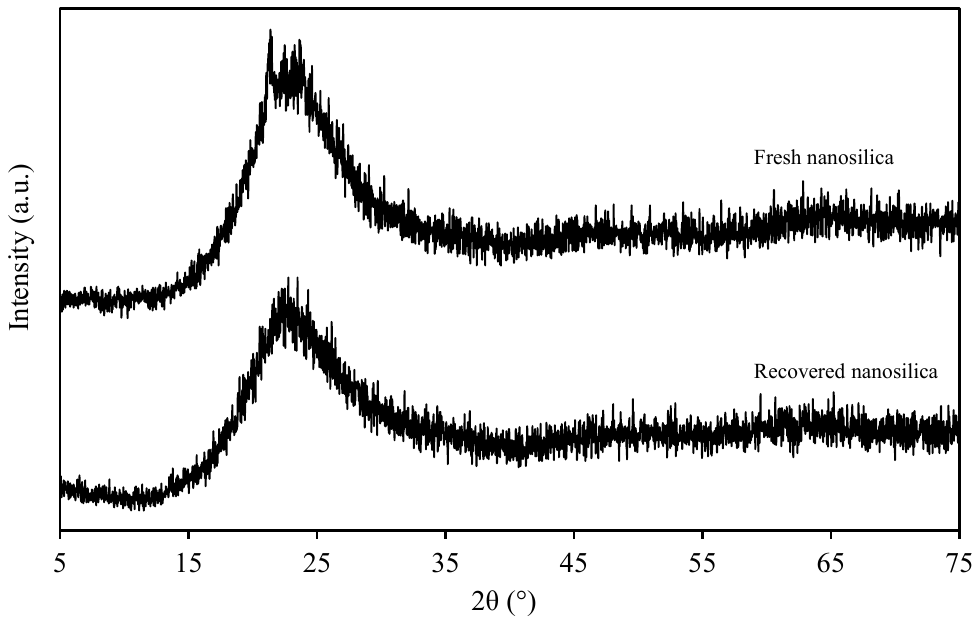
Figure 7. XRD analysis of fresh and recovered nanosilica.